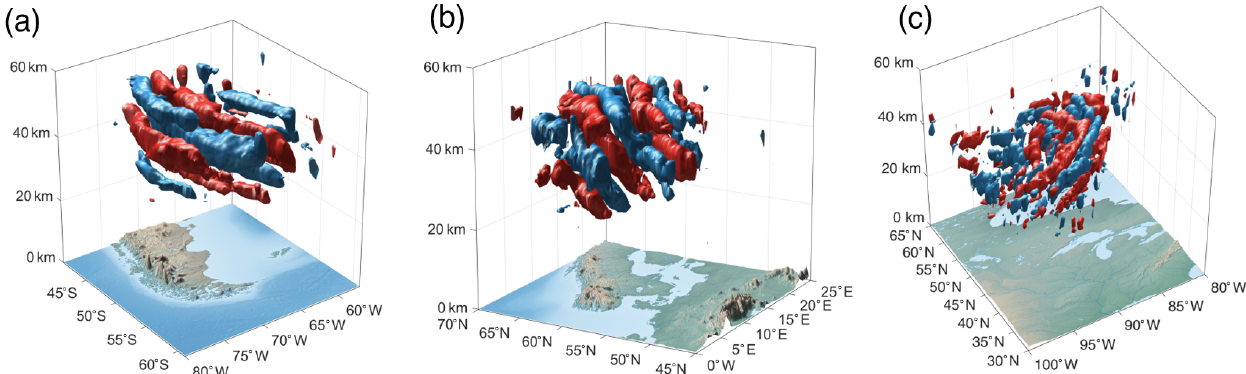
Figure 5. A trio of 3D sketches of the three waves used as case studies; amplitudes have been omitted as these are shown in cross section below (Figs. 6–8). Viewing angles have been selected to best highlight the 3D phase structure of each case.